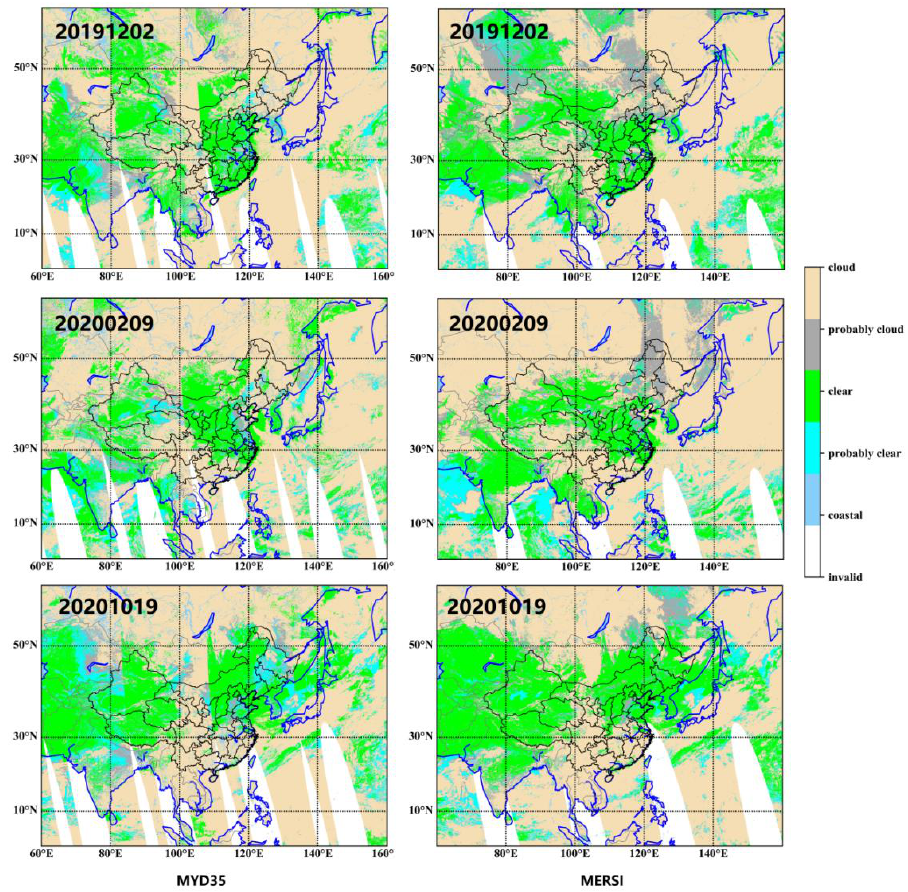
Figure 9. Aqua/MODIS cloud mask (left) and MERSI operational cloud mask (right), these three lines represent the distribution on 2 December 2019, 9 February 2020 and 19 October 2020, respectively.